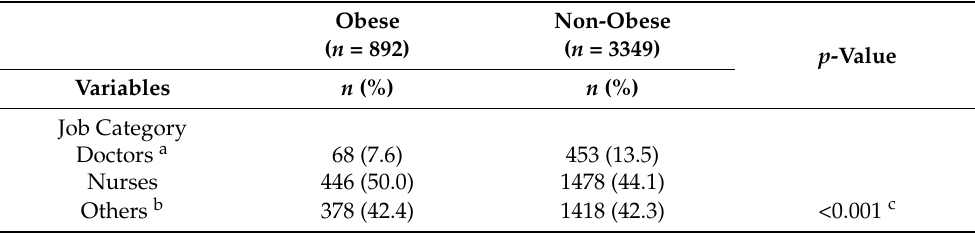
Table 3. Obesity by job categories ( n = 4241).